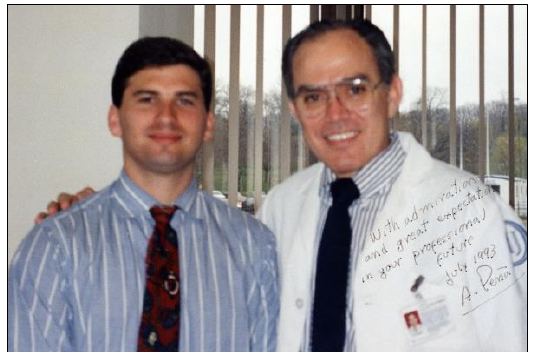
Figure 1: Marc Levitt and Alberto Pena in